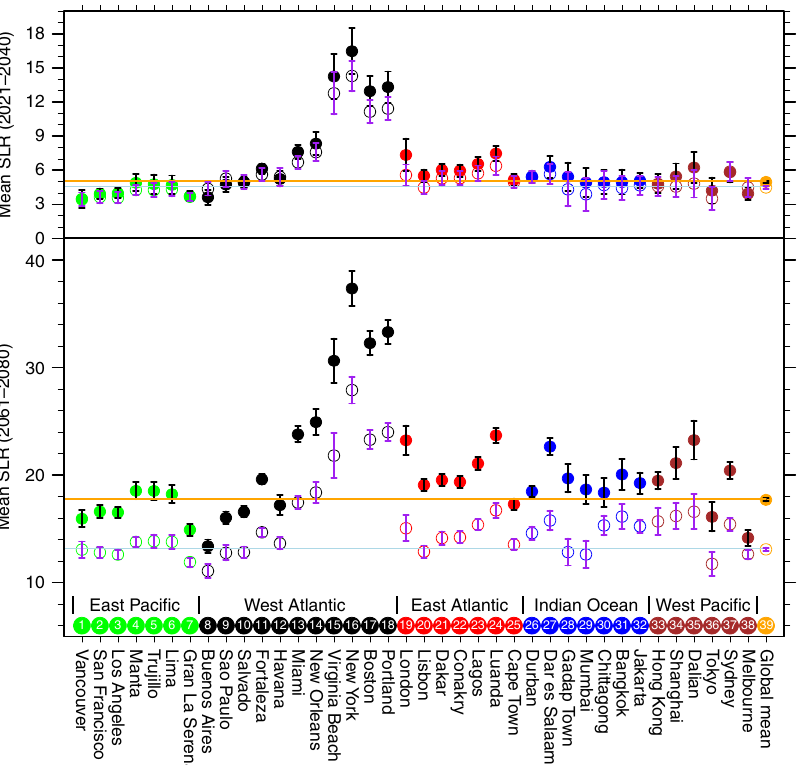
Fig. 2 Twenty-year mean sea level rise for selected cities. This mean sea level rise is relative to the mean of the 1986 – 2005. The top is for the mean of 2021 – 2040 and the bottom for 2061 – 2080. The geographic location of these cities is given in Supplementary Fig. 7. The solid dots are the ensemble mean sea level rise for RCP8.5 and open circles the ensemble mean sea level rise for RCP4.5. The bars indicate ensemble variability (±1 standard deviation). The units are in centimeters. The brown and light blue line represent the ensemble global mean SLR for RCP8.5 and RCP4.5, respectively. The color coded dots/ open circles represent east (green) and west (brown) Paci fi c coasts, west (black) and east (red) Atlantic coasts, and Indian Ocean coast